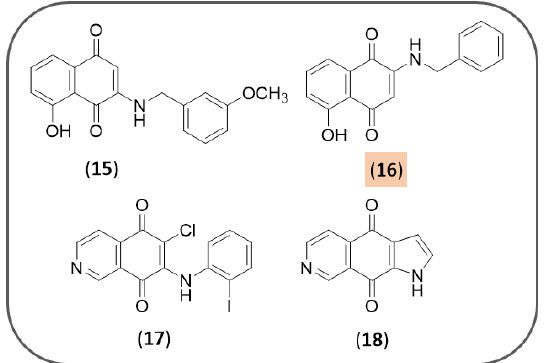
Figure 6. Synthetic NQ investigated by N. Neo Shin et al. as amyloid imaging agents.